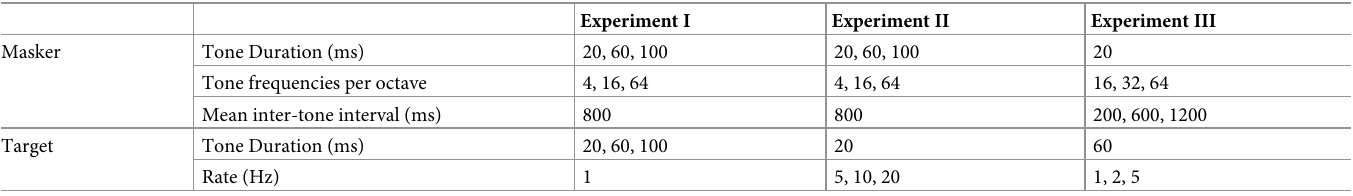
Table 1. Parameters of the experimental settings for the three experiments.